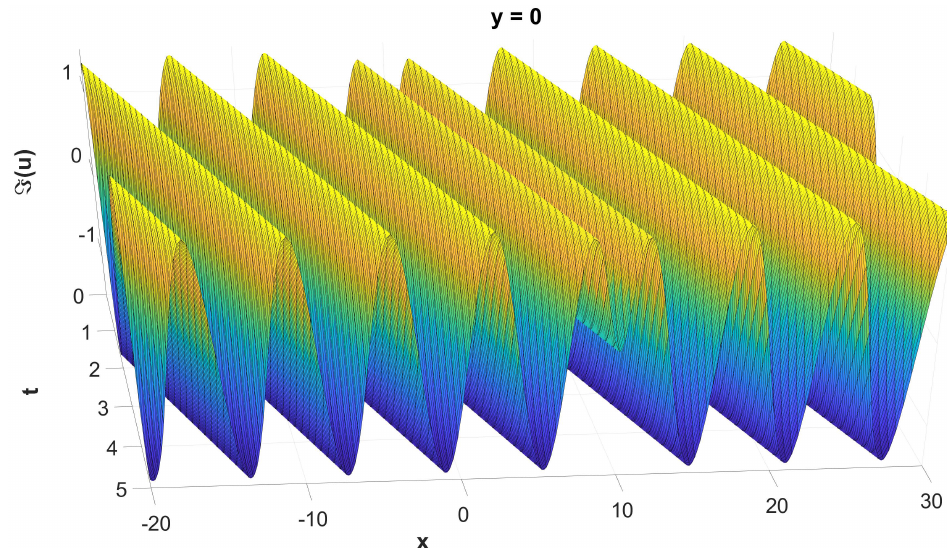
Figure 6. The graph of (cid:60)